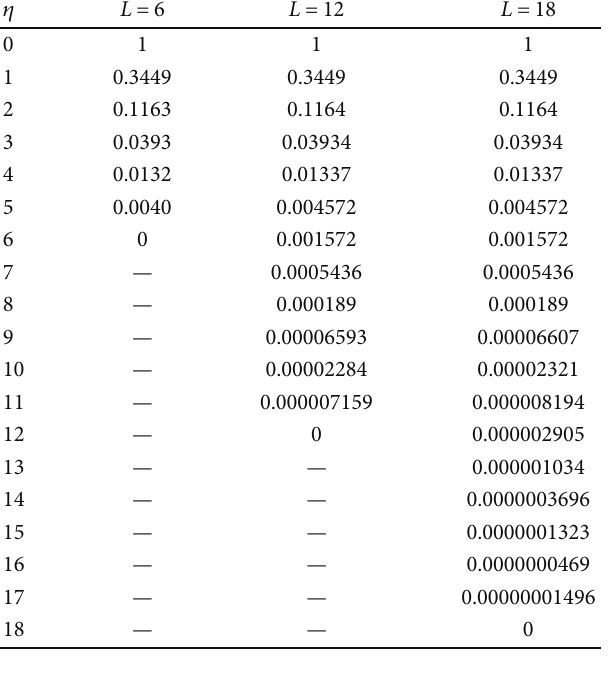
Table 3: Velocity pro fi le via hybrid